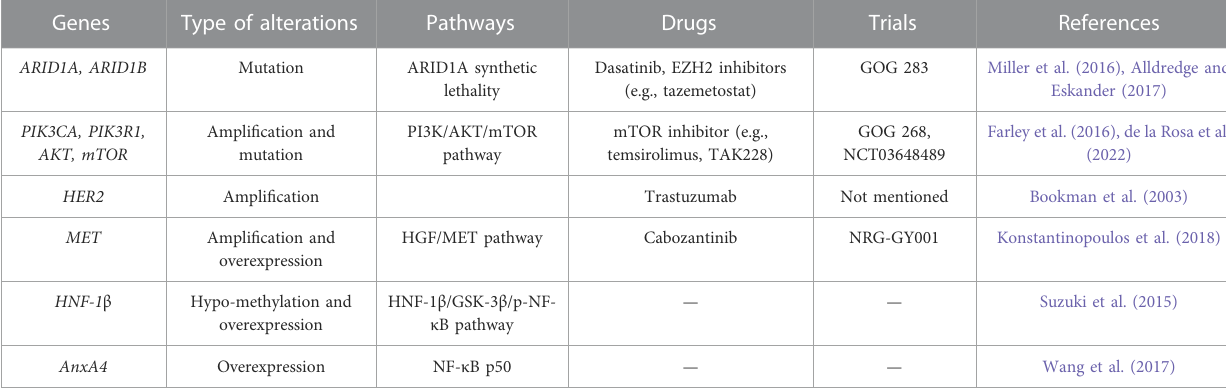
TABLE 1 Summary of the gene alterations and associated clinical trials in ovarian clear cell